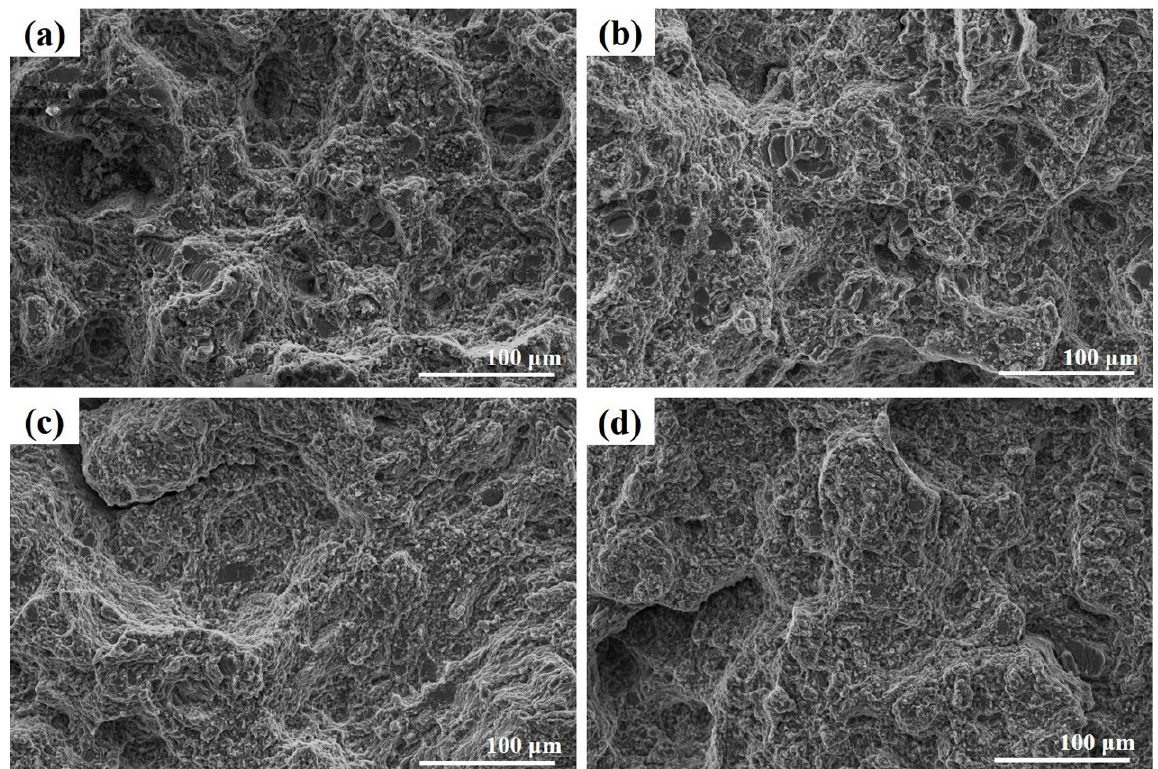
Figure 6. Tensile fracture morphology of extruded AZ91 and AZ91-CaO alloy :( a ) AZ91-T4-EX, ( b ) AZ91-T6-EX, ( c ) AZ91-CaO-T4-EX, ( d ) AZ91-CaO-T6-EX.